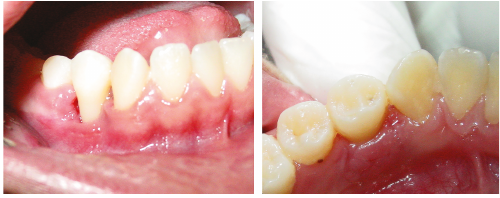
Figure 8: Aspect after seven days